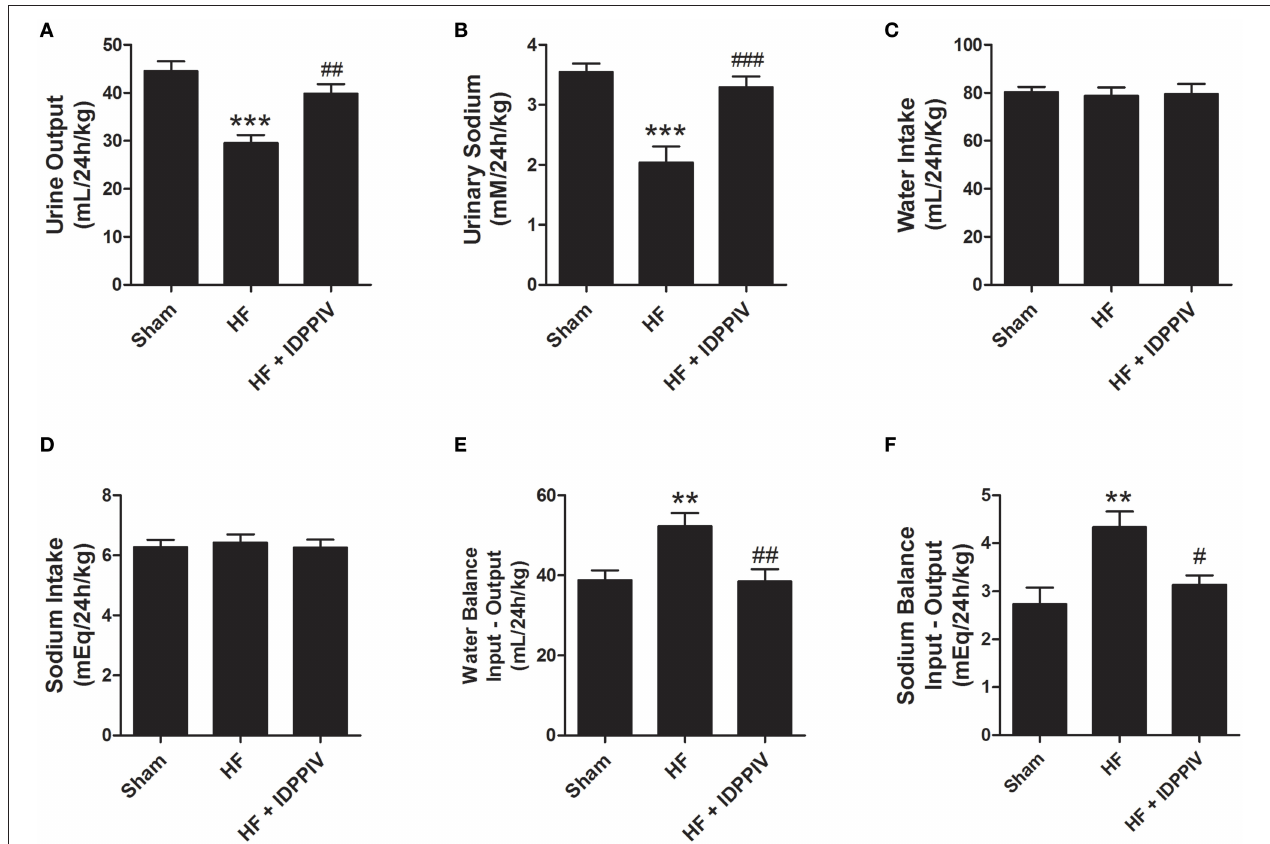
FIGURE 6 | DPPIV inhibition by vildagliptin improves renal handling of sodium and water of HF rats. Sham and HF rats treated with vildagliptin (HF + IDPPIV) or vehicle (HF) were individually placed into metabolic cages for 24-h urine collection for three consecutive days to evaluate (A) urinary flow and (B) urinary Na + excretion. (C) Water and food consumption were measured daily. (D) Sodium intake was calculated based on the sodium content of the rodent chow and on the daily consumption of chow by each rat. (E) Water and (F) sodium balance. n = 11–17 rats/group. Values are means ± SEM. ** p < 0.01 and *** p < 0.001 vs. Sham. # p < 0.05, ## p < 0.01, ### p < 0.001 vs.